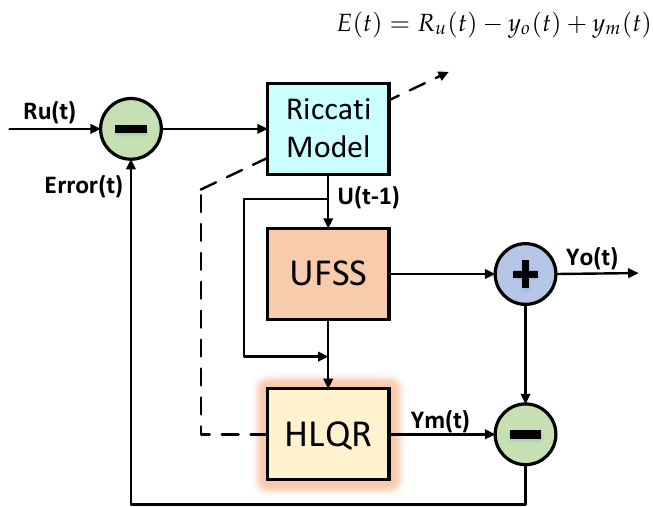
Figure 9. Adaptive structure for HLQR along with